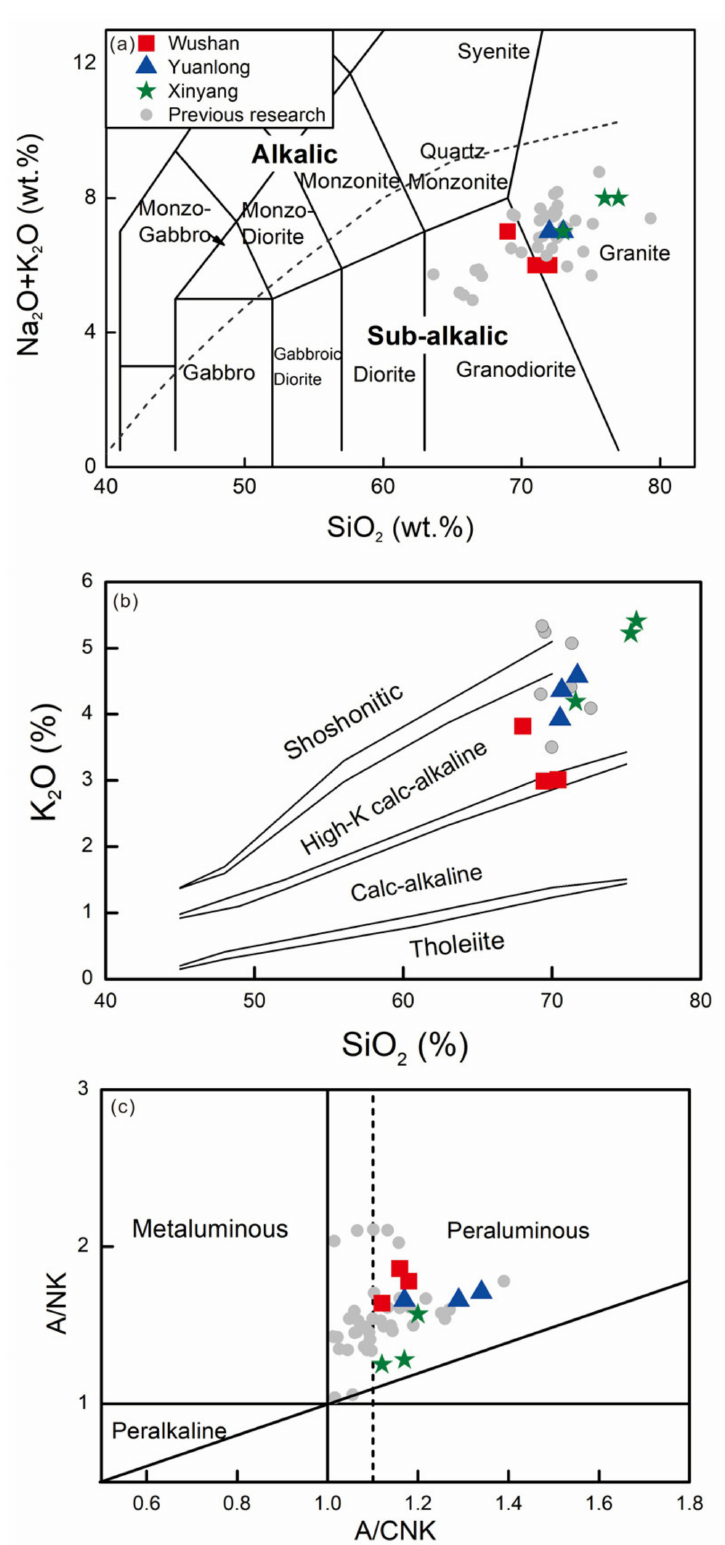
Figure 4. Major element compositions of the studied granitic mylonites and granitic gneisses from the western margin of the NQT: ( a ) total alkalis versus silica (TAS; after [85]) classification diagram; ( b ) K 2 O versus SiO 2 classification diagram [86]); ( c ) alumina saturation index diagram [87]. Data sources for the previous research: